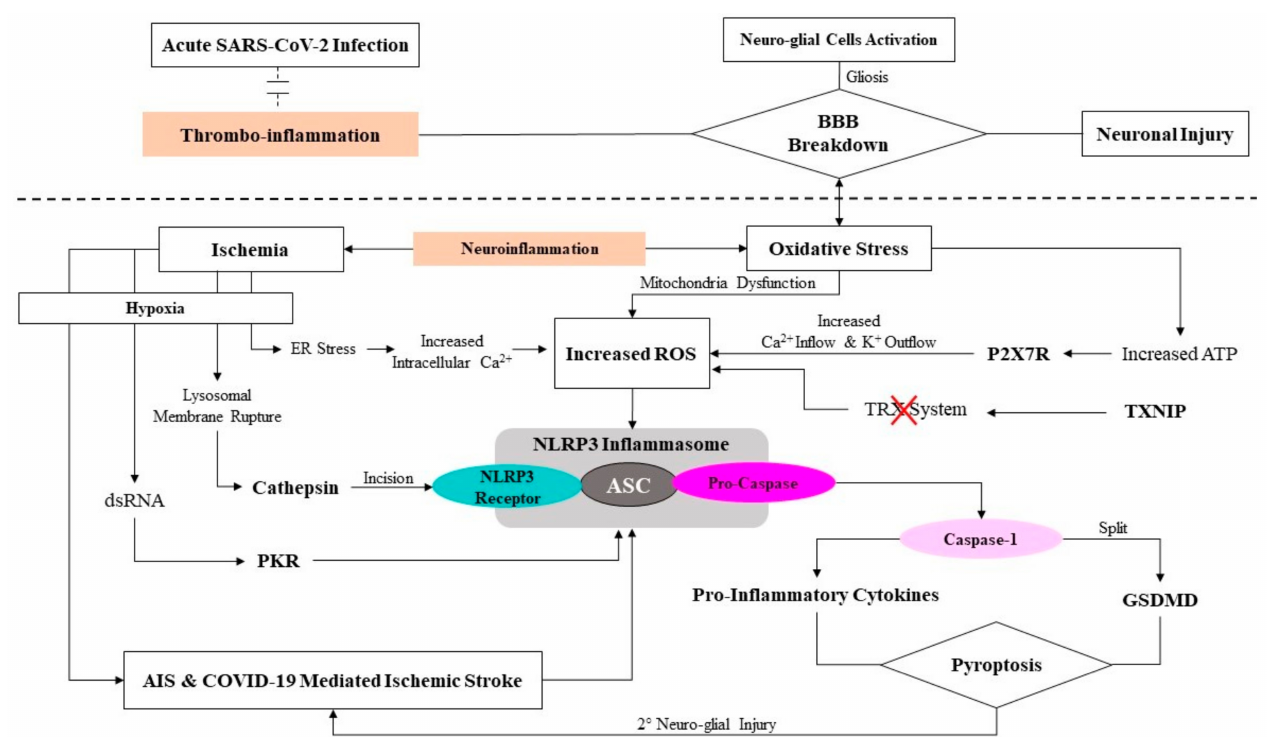
Figure 3. Brief mechanism of NLRP3 inflammasome activation and its role in acute ischemic stroke (AIS) and COVID-19-mediated ischemic stroke. Upon viral infection and subsequent increases in thrombo-inflammation and blood–brain barrier (BBB) breakdown, the heightened oxidative stress promotes higher activity of adenosine triphosphate (ATP), activating purinergic ligand-gated ion channel 7 receptor (P2X7R), thereby increasing calcium ion (Ca 2+ ) inflow and potassium ion (K + ) outflow. These, in turn, increase reactive oxygen species (ROS) production. A higher production of ROS can also be induced by oxidative-stress-mediated mitochondrial dysfunction and the inhibition of the thioredoxin (TRX) system by TRX-interacting protein (TRXNIP). The increased ROS then activates the NLRP3 inflammasome. Furthermore, increased ROS-mediated NLRP3 inflammasome can also be mediated by ischemic mediated endoplasmic reticulum (ER) stress, which increases intracellular Ca 2+ lysosomal membrane rupture, which in turn activates NLRP3 receptor incision through cathepsin and activated protein kinase R (PKR) by double-stranded RNA. The activated NLRP3 inflammasome promotes the pro-caspase self-cleavage into caspase-1; next, the caspase-1 lyses and activates gasdermin-D-mediated cell death (GSDMD) and pro-inflammatory cytokines (i.e., interleukin-18 and -1 β ), leading to neuro-glial cell death or pyroptosis, inducing or worsening AIS or COVID-19-mediated ischemic stroke. ASC, apoptosis-associated speck-like protein containing a CARD